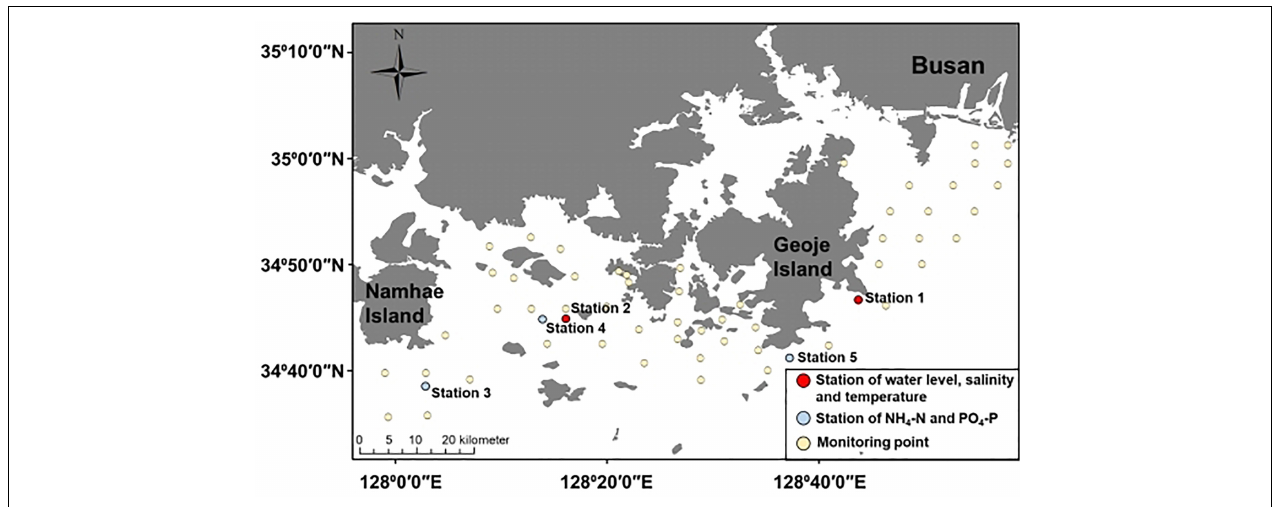
FIGURE 1 | Study site—red dots indicate the observation station for water elevation, salinity, and temperature; blue dots indicate the observation point for NH 4 -N and PO 4 -P; yellow circles indicates the monitoring point for A. catenella